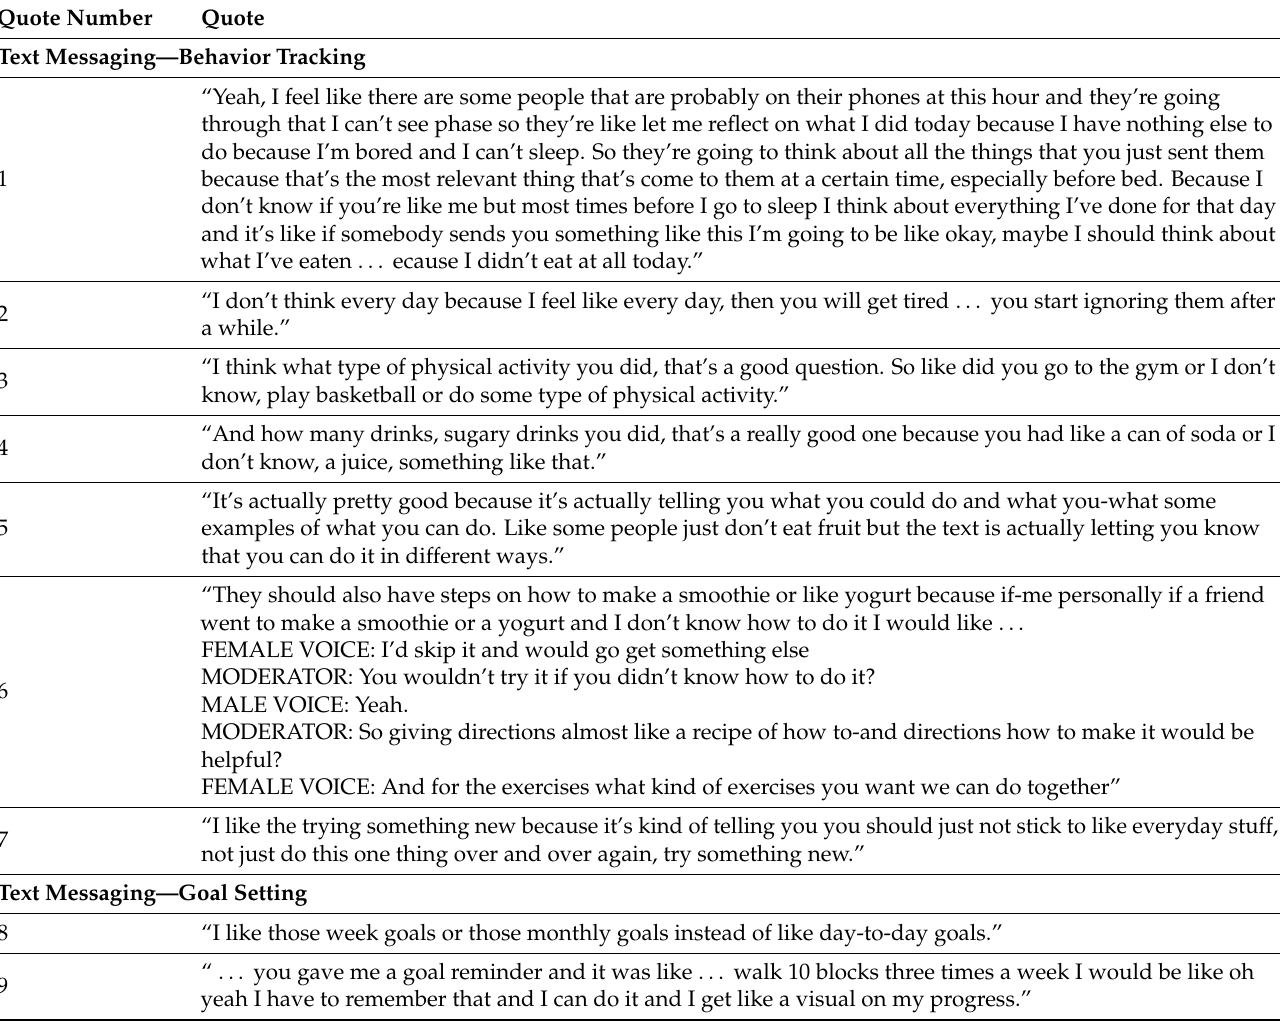
Table 3. Representative Subthemes and Supporting Quotes for Theme 3: Adolescents prefer text messaging for motivation and support, and to monitor key diet and physical activity behaviors, track weekly goals, and receive personalized advice and